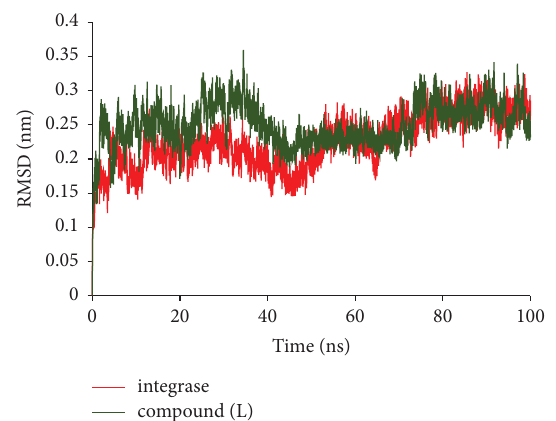
Figure 7: Plot of RMSD alpha carbon integrase during 100 ns of simulation in connection with compound (l) for integrase in red and for integrase with compound (L) in green.